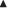
Infrared spectra of [Zn(phen)(van)2] (ZPV) complex (black), the Schiff base vglu (red), the chitosan membrane modified with [Zn(phen)(van)2], CS-ZPV (blue), and chitosan (CS) membrane (green). Symbols represent the νC
=
N(), νC = C of phenanthroline and vanilloid group () and δC-H and δO-H of the glucosidic ring (). The region of the glycosidic ring νC-O-C and β-(1-4) glycosidic bridge, from 1218 to 919 cm-1, were omitted to allow a better view of less intense bands.